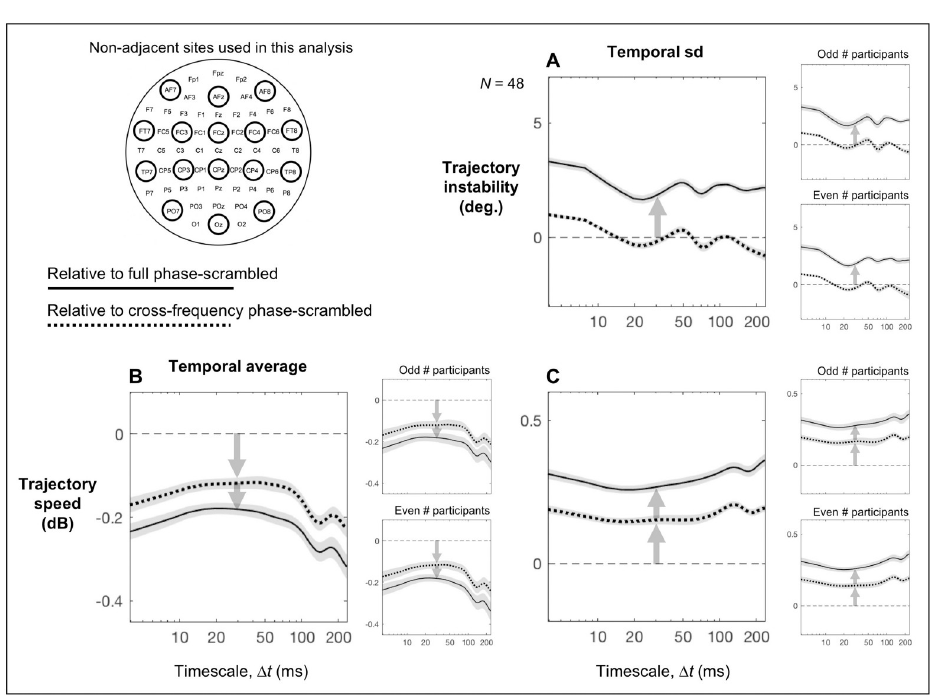
Fig 10. An evaluation of potential contributions of volume conduction to the effects attributable to cross-site phase synchronization. Because volume conduction effects are negligible beyond adjacent scalp sites on a standard 64-site array after applying the surface-Laplacian transform (e.g., [35]), we re-evaluated the effects that may be susceptible to volume conduction, (A) increases in the temporal variability in trajectory instability, (B) reductions in time-averaged trajectory speed and (C) increases in its temporal variability, for state trajectories of a global array comprising 16 non-adjacent sites (see upper left). The effects should minimize if volume conduction played substantial roles in the original analyses. The effects relative to the full phase-scrambled controls are shown with solid lines and those relative to the cross-frequency phase-scrambled controls are shown with dotted lines. The shaded areas represent ± 1 standard error of the mean. A. The temporal variability (measured as temporal standard deviation) in trajectory instability as a function of timescale Δ t relative to the phase-scrambled controls. It was consistently elevated relative to the full phase-scrambled control across all timescales, but was largely at the level of the cross-frequency phase- scrambled control, replicating the original analyses presented in Figs 4C and 5C. B. Time-averaged trajectory speed as a function of timescale Δ t relative to the phase-scrambled controls. It was consistently reduced relative to both the full and cross-frequency phase-scrambled controls across all timescales, and consistently more reduced relative to the full than cross-frequency phase-scrambled control across all timescales. These results replicate the original anlayses presented in Figs 4B and 5B. C. The temporal variability (measured as temporal standard deviation) in trajectory speed as a function of timescale Δ t relative to the phase-scrambled controls. It was consistently elevated relative to both the full and cross-frequency phase-scrambled controls across all timescales, and consistently more elevated relative to the full than cross-frequency phase-scrambled control across all timescales. These results replicate the original analyses presented in Figs 4D and 5D. For each plot, the reliability of the data patterns is demonstrated by the accompanying plots on the right showing virtually identical patterns obtained from the odd and even numbered